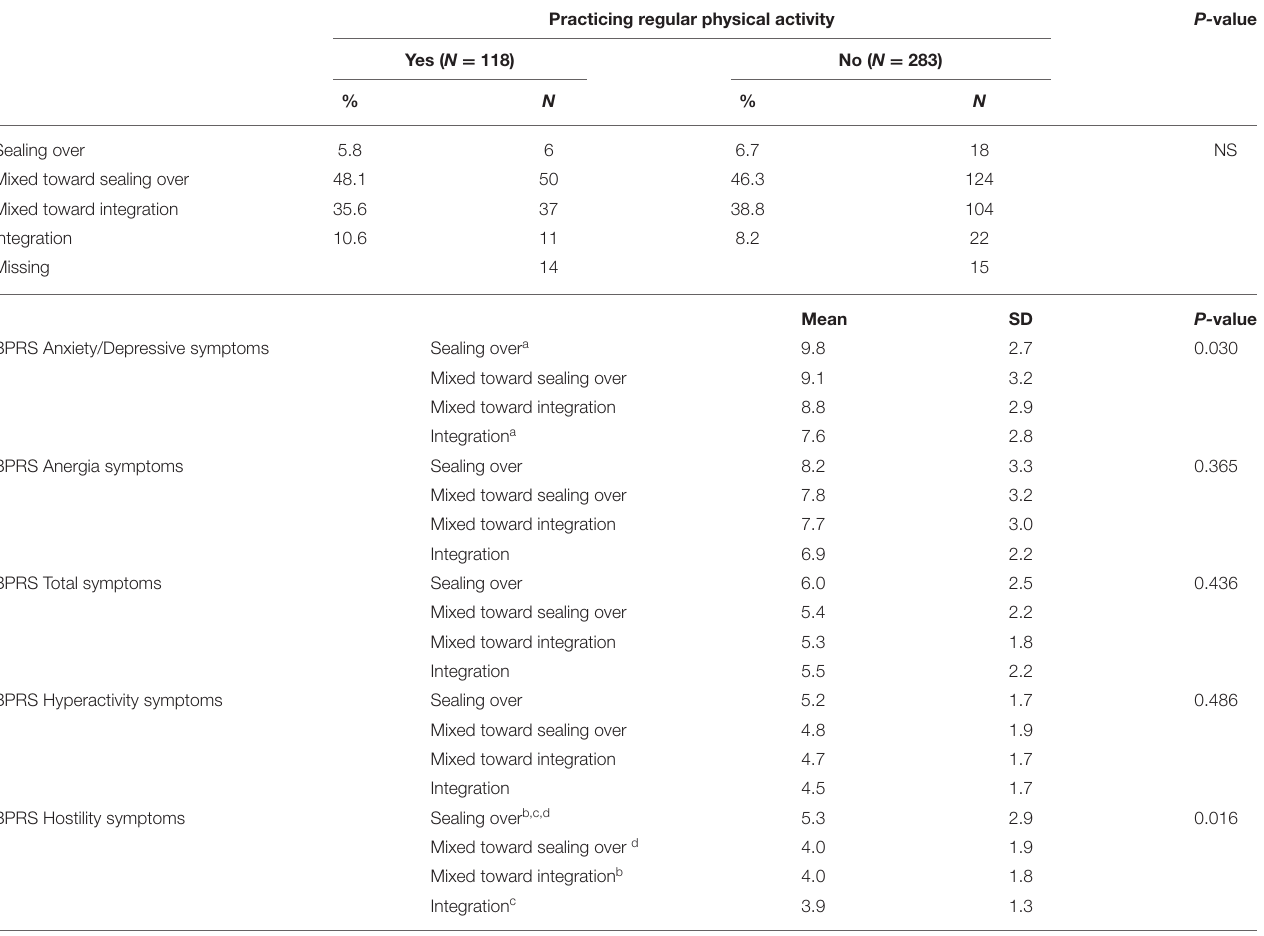
TABLE 2 | Differences in recovery styles according to practicing regular physical activity and to symptoms’ severity. Practicing regular physical activity